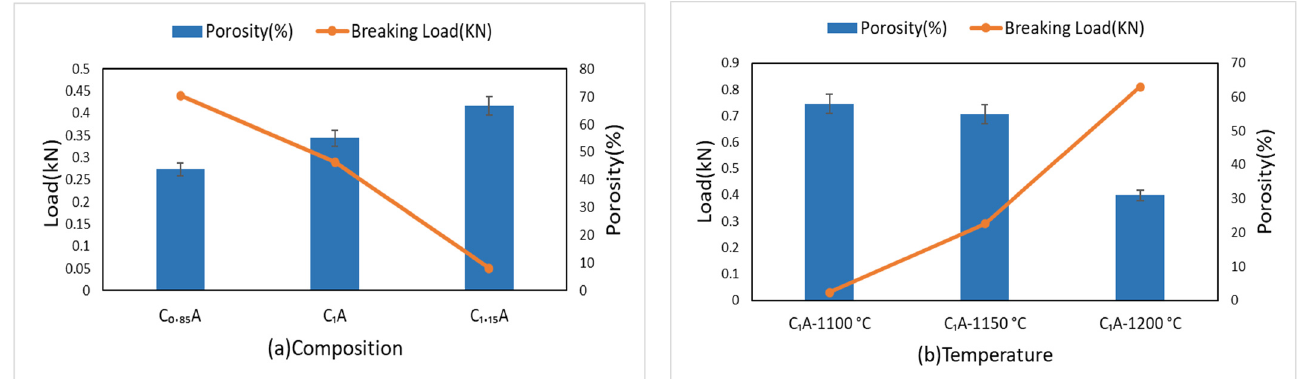
Figure 14. Porosity vs. breaking load of different compositions at fixed sintering temperature 1150 °C ( a ), and at different temperatures for fixed composition C 1 A ( b ).